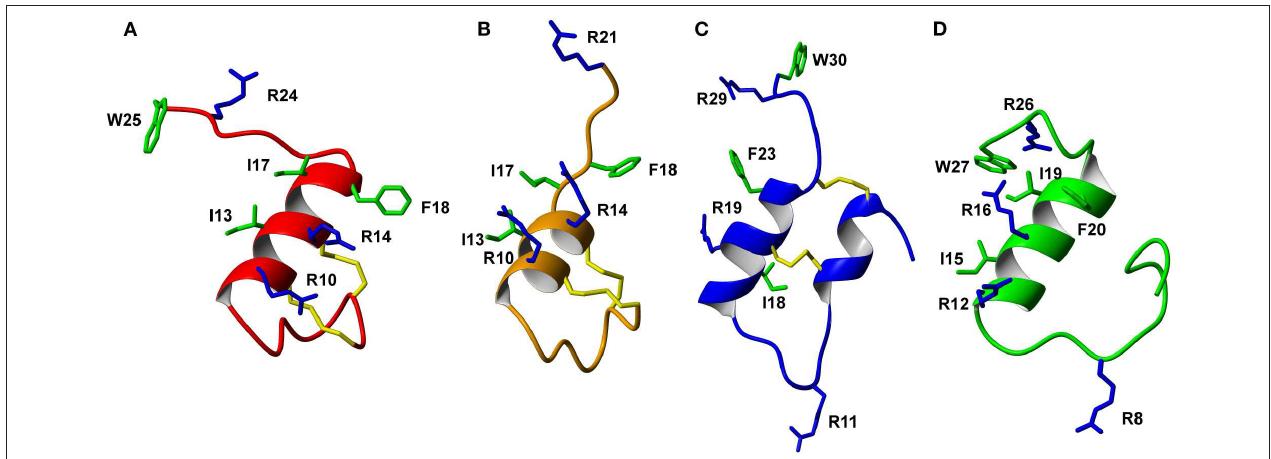
FIGURE 6 | Comparison of the solution NMR structures of (A) analog 3 , (B) analog 9 , (C) analog 5, and (D) analog 1 (B-chain only). The grafted apamin analogs (A,B) and grafted VhTI (C) analog show overall secondary structure similar to the native H3 relaxin B-chain (D) . The grafted RXFP3 binding and activating residues are shown, highlighting differences in the positioning of the receptor binding motif in the various analogs.